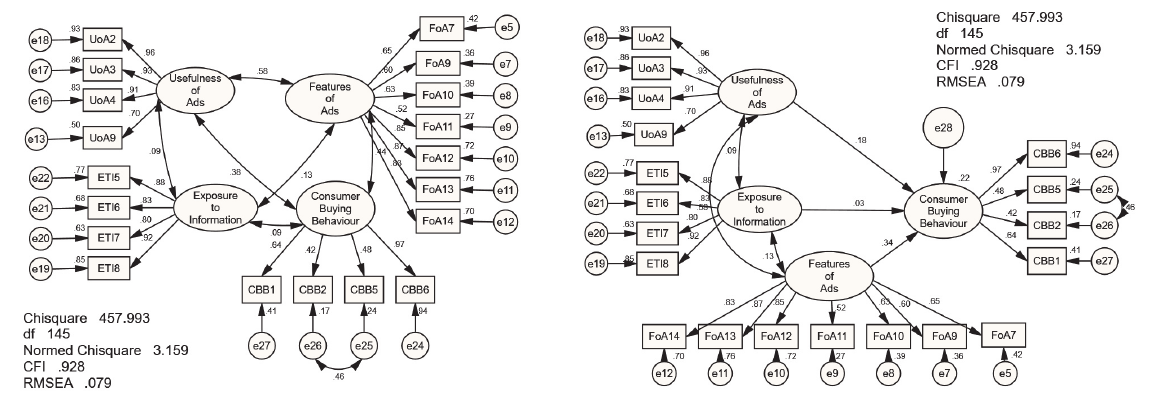
Fig. 2. Confirmatory Factor Analysis Fig. 3. Full Structural Model